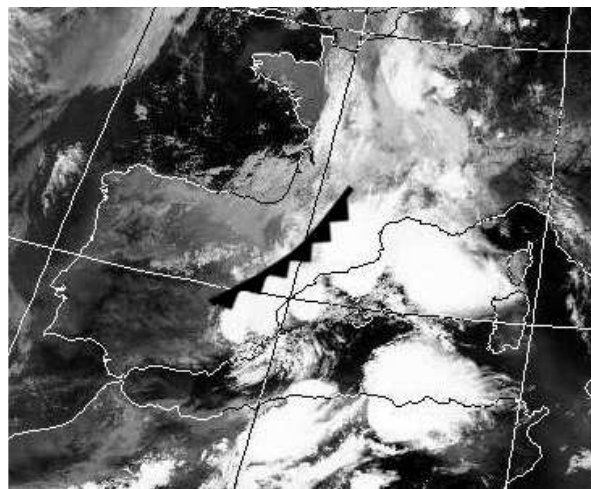
Fig. 1. The NOAA satellite image (channel 4, infrared) of the Iberian Peninsula shows the position of the cold front at 19:00 UT on 14 September 1999.